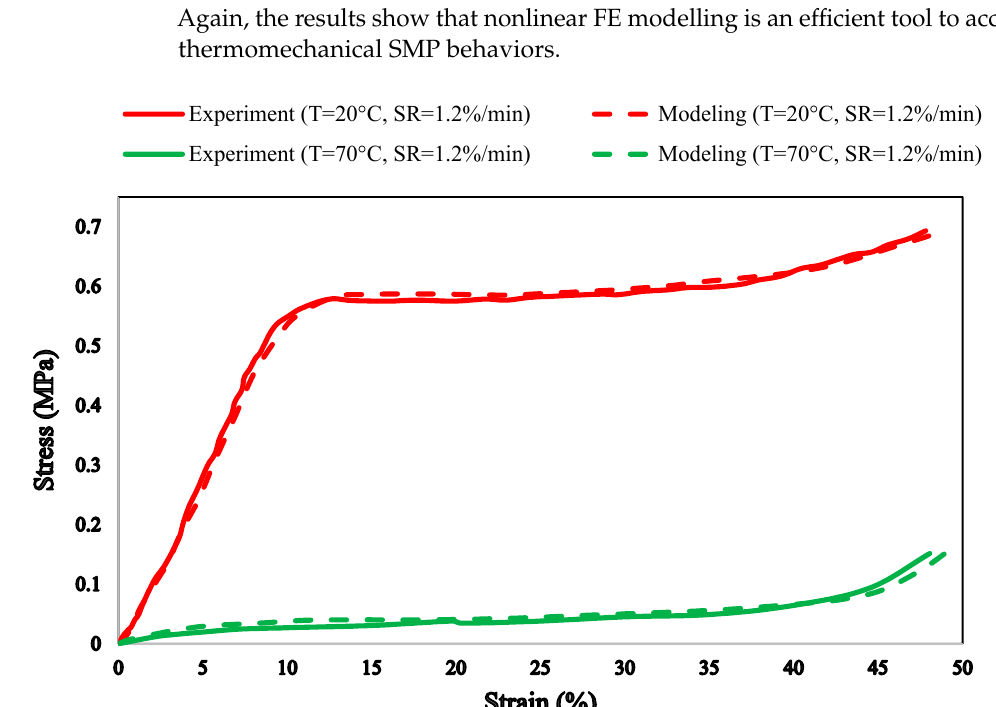
Figure 10. Comparison of numerical and experimental stress-strain behaviors of PU SMP foams under a compressive load and at different temperatures with a strain rate of 1.2%/min.